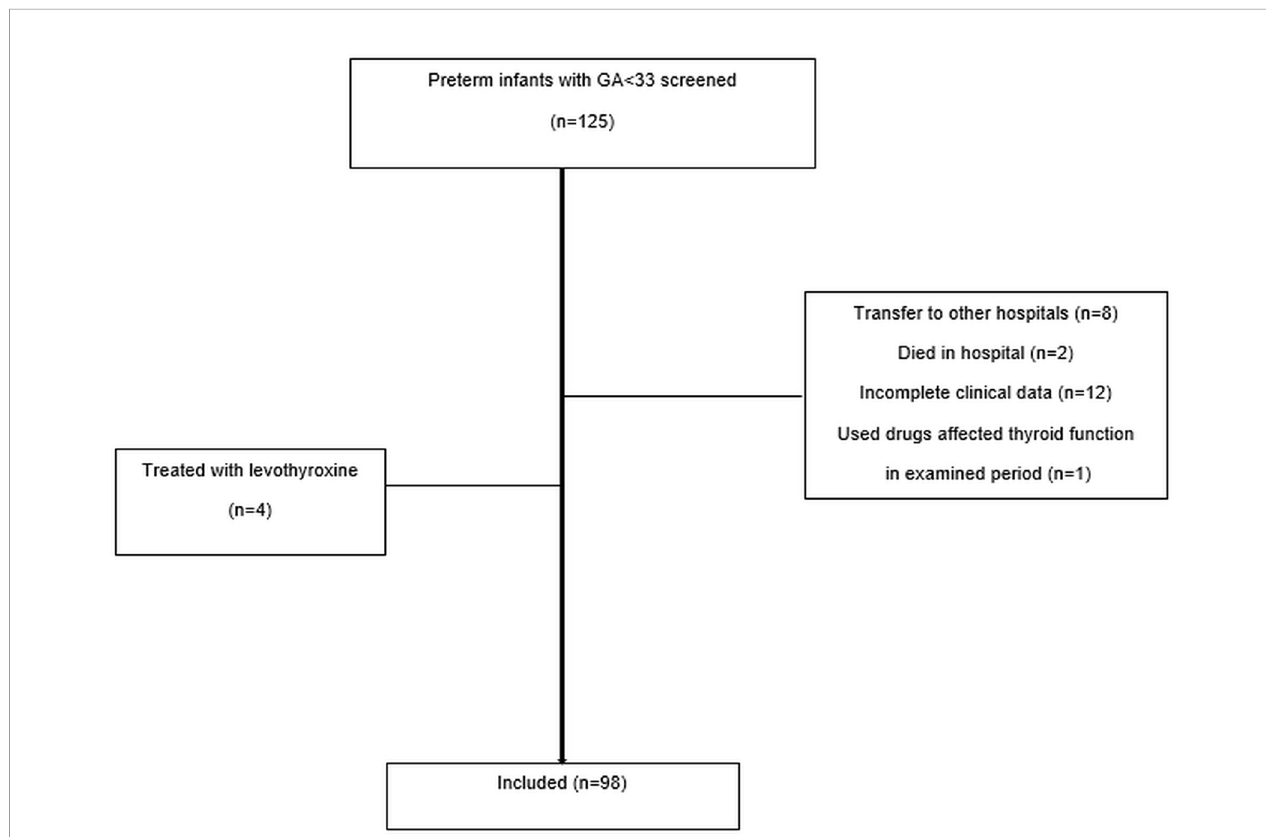
FIGURE 1 | Flow chart of distribution of preterm infants